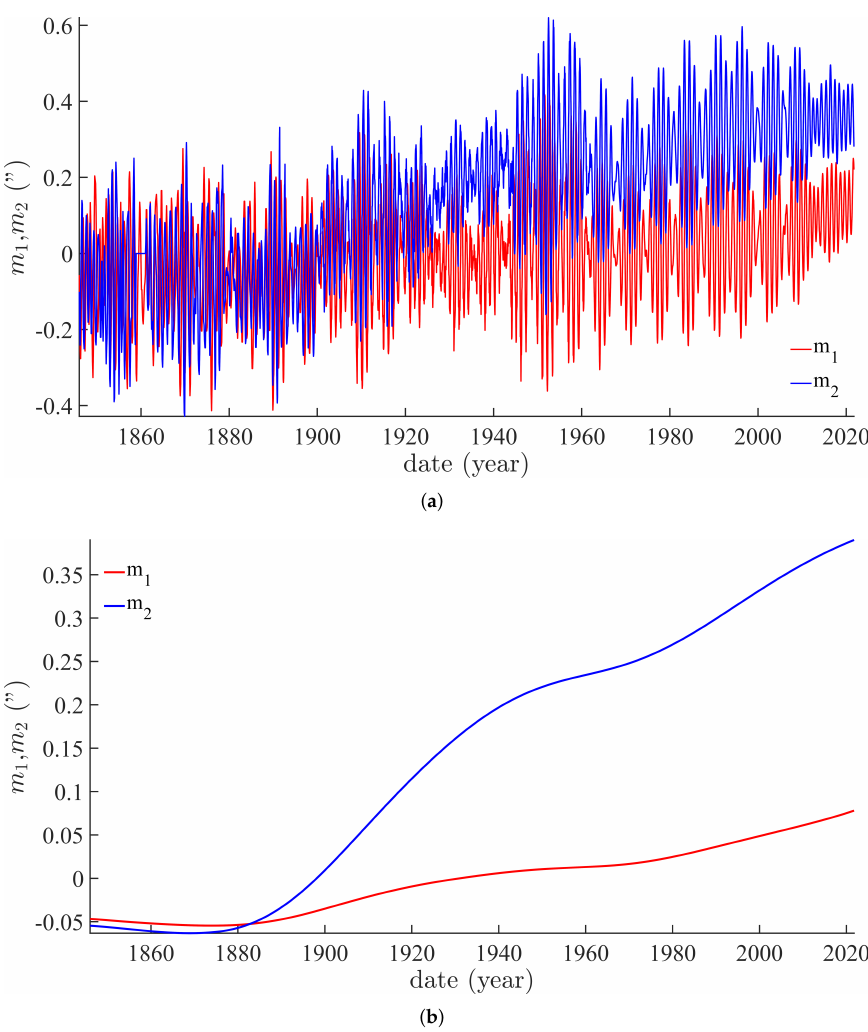
Figure 3. Polar motion from IERS . ( a ) The m 1 and m 2 components of polar motion from IERS (from 1846 to the Present). ( b ) The trends of components m 1 and m 2 from 1846 to the Present, extracted using SSA